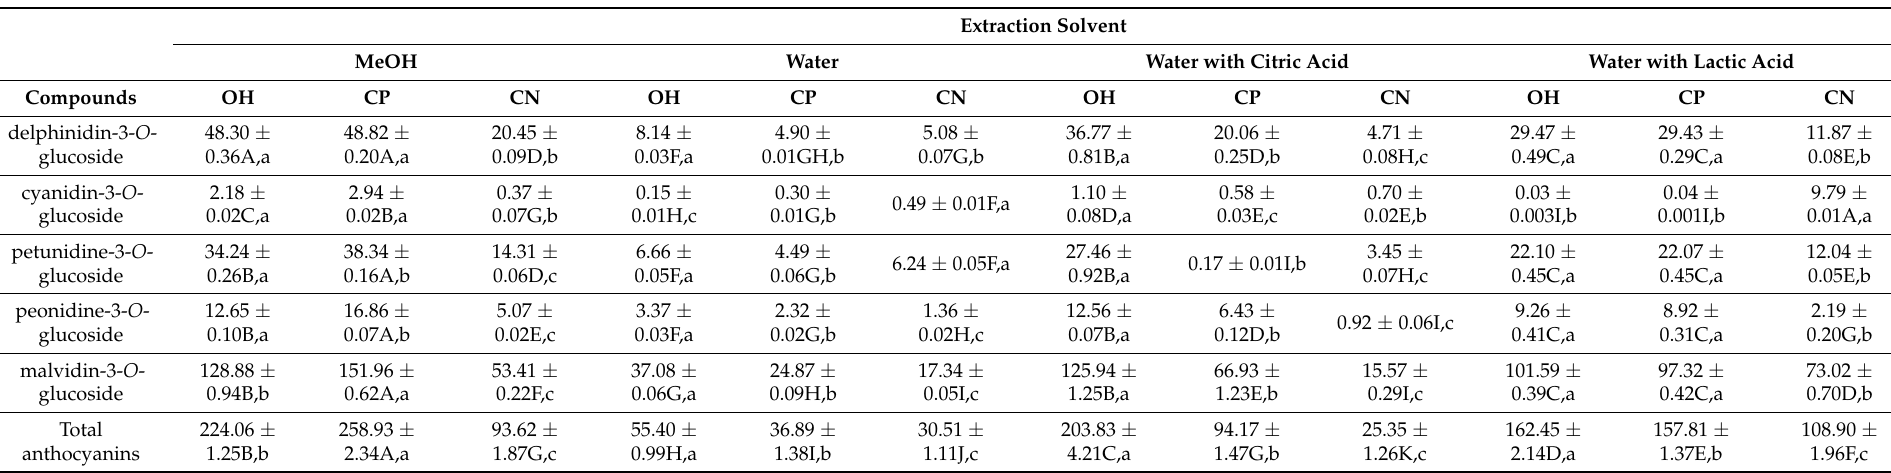
Table 1. Anthocyanins profile from OH, CONV, and CT methods for each solvent ( µ g/g DW). Extraction